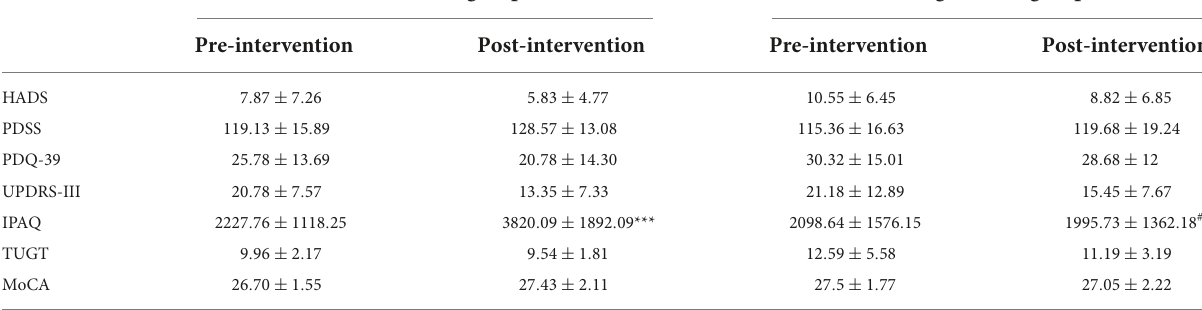
TABLE 2 Pre- and post-intervention questionnaire scores of patients with